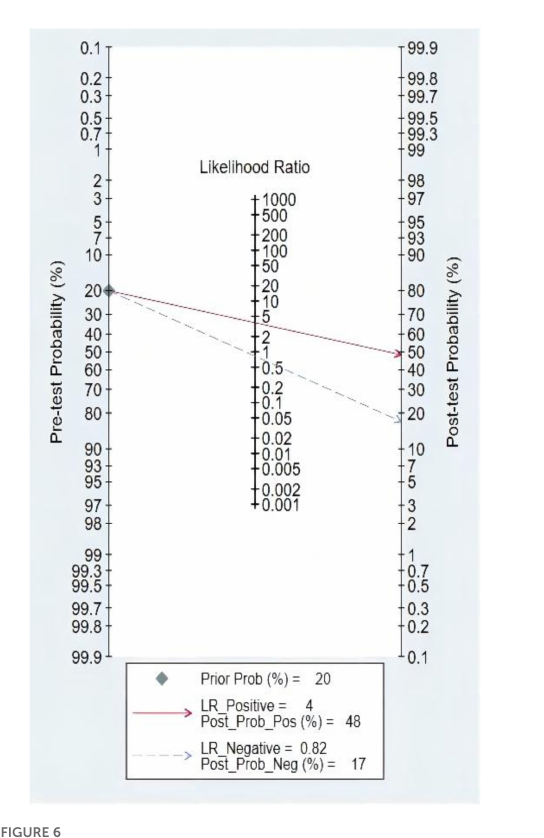
FIGURE6 Fagan diagram of third heart sound (S3) in the diagnosis of heart failure